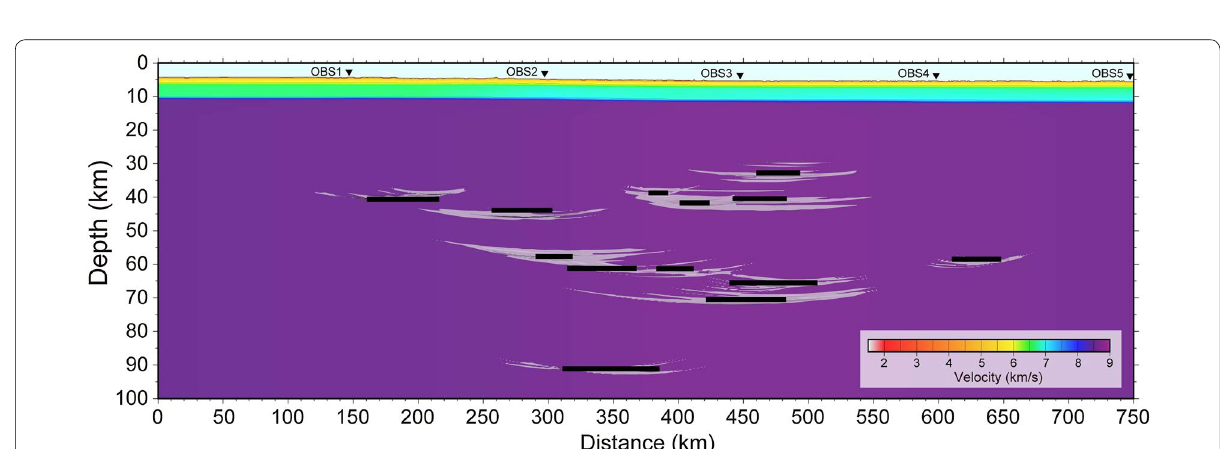
Fig. 13 Results of the travel time mapping and ray tracing for the DRs shown in Figs. 10, 11, and 12. The background P -wave velocity model was used to determine reflection travel time picks. Diffraction surfaces are shown as white curves. Black bars indicate reflection points for the DRs on all OBS